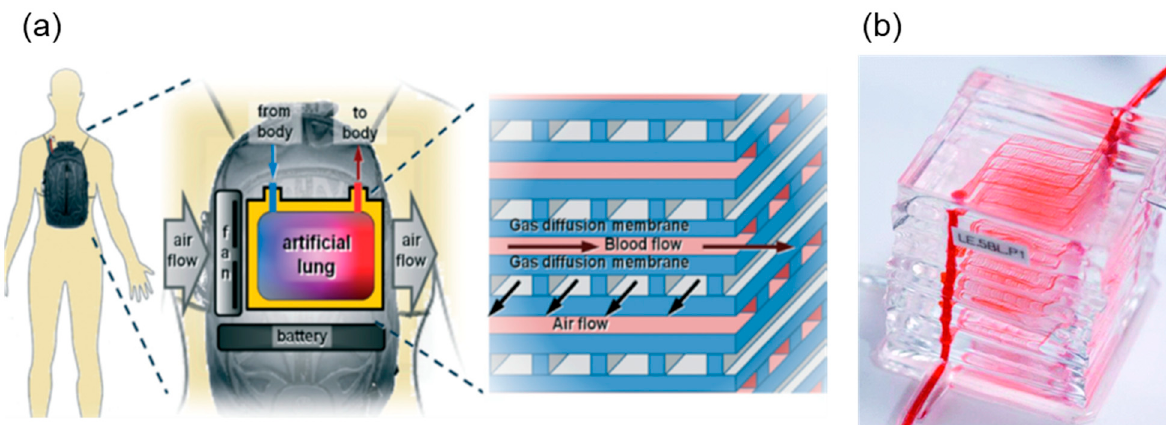
Figure 10. ( a ) A conceptual drawing of an initial clinical application of microfluidic artificial lung technology—an ambulatory pumpless extracorporeal lung assist system (reprinted with permission from [128]); ( b ) a multilayer PDMS microfluidic blood oxygenator (reprinted with permission from